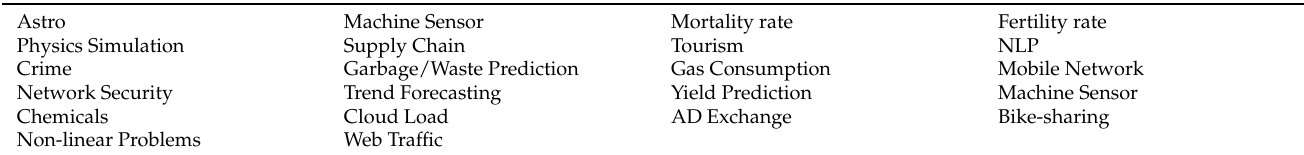
Table 2. A collection of domains that occurred less than three times in the paper